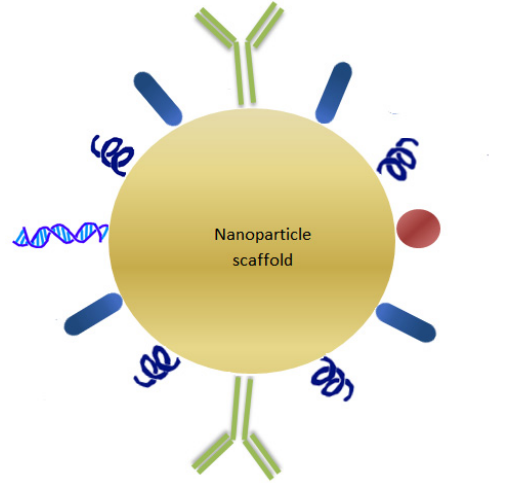
Figure 3. Hypothetical biofunctionalized, multifunctional nanopharmaceutical with the following